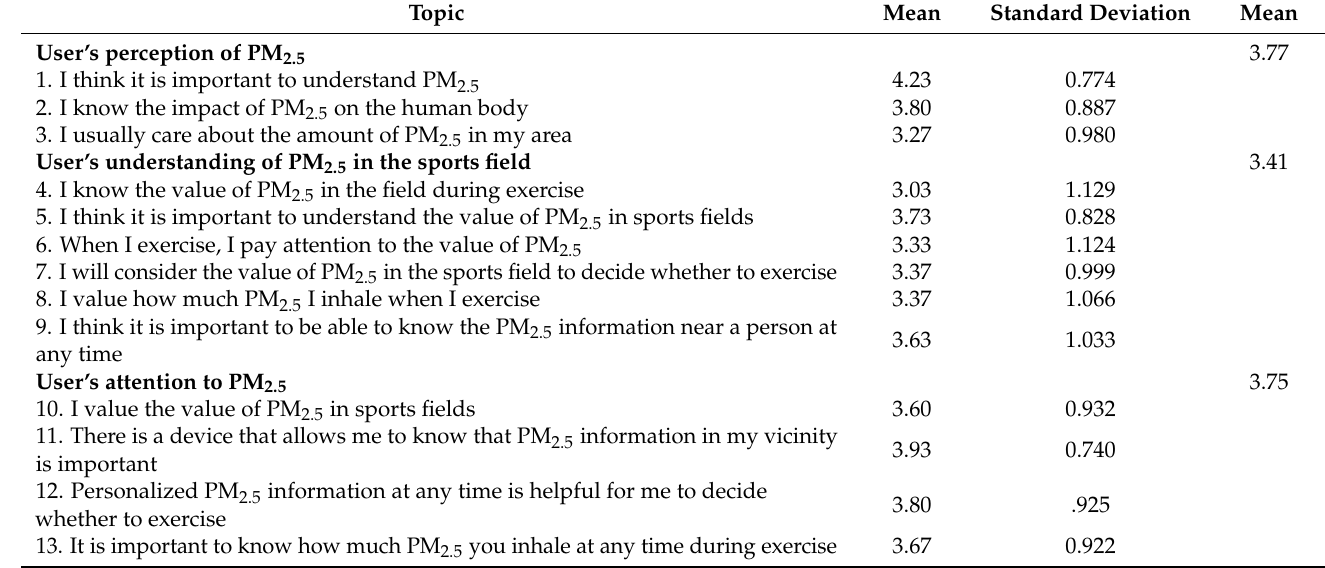
Table 3. Questionnaire analysis of users’ perception of PM 2.5 during exercise. Topic Mean Standard Deviation